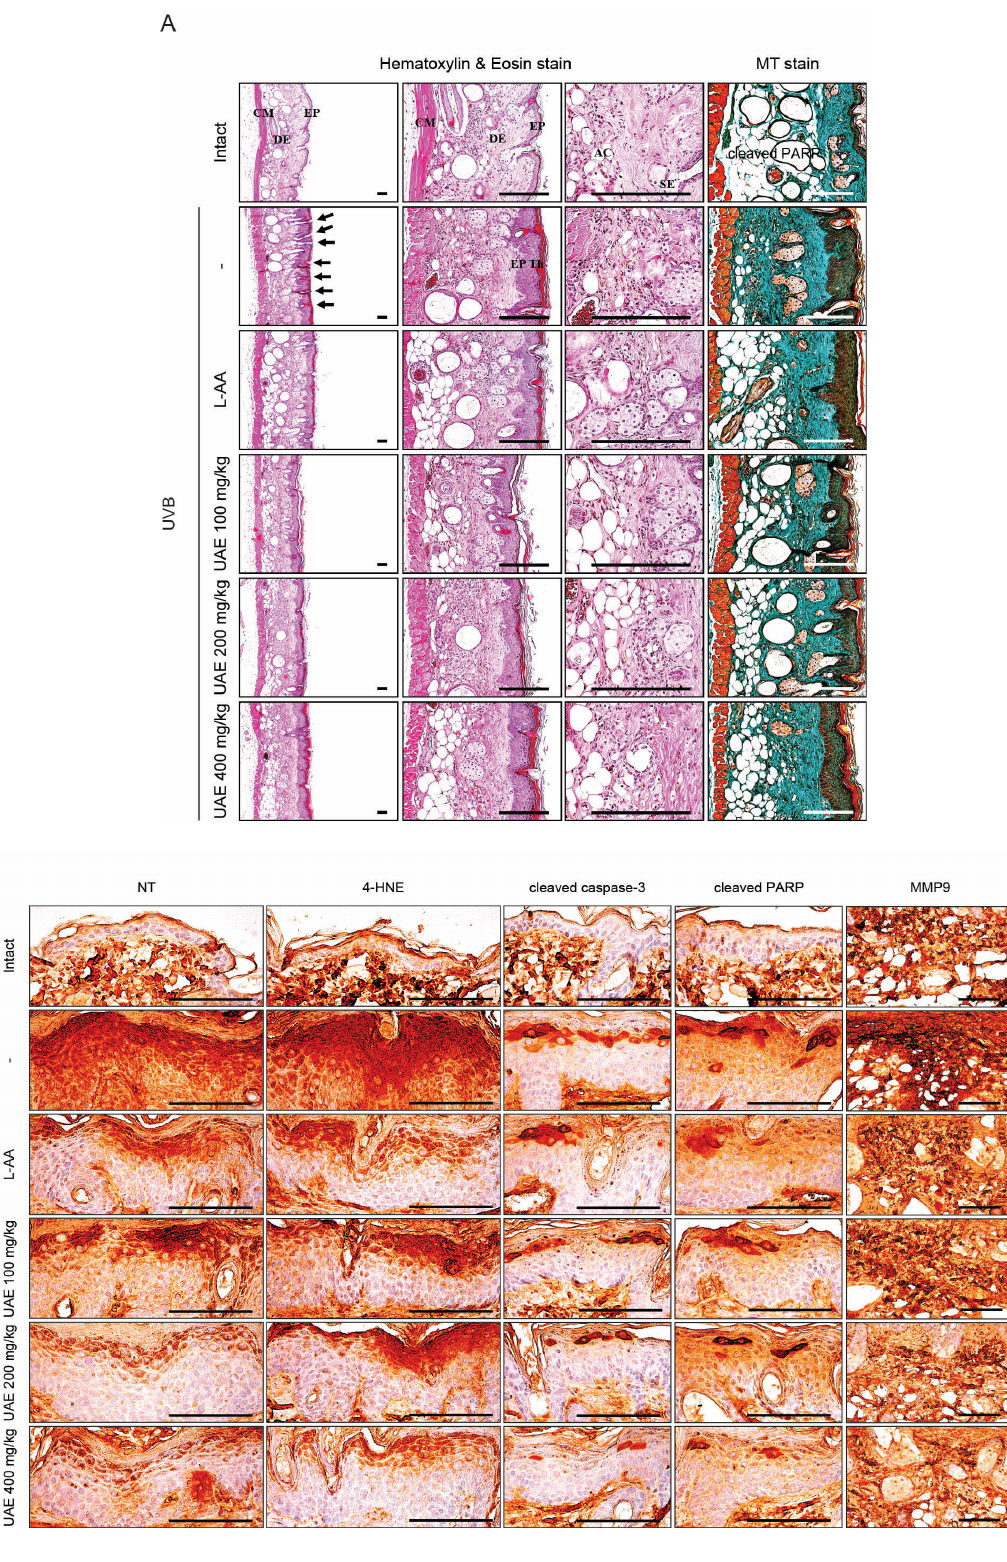
Figure 5. ( A ) Representative images of stained skin tissue with hematoxylin and eosin or Masson’s trichrome (MT). Arrows indicate microfolds in skin epithelial surface. Scale bars indicate 200 µm. ( B ) Immuno-stained skin tissue using nitrotyrosine (NT), 4-hydroxynonenal (4-HNE), cleaved caspase-3, cleaved PARP, and MMP9 antibodies. Scale bars indicate 100 µm. EP, epithelium; DE, dermis; CM, cutaneous muscle; SE, sebaceous gland; AC, adipocyte; Th, thickness.